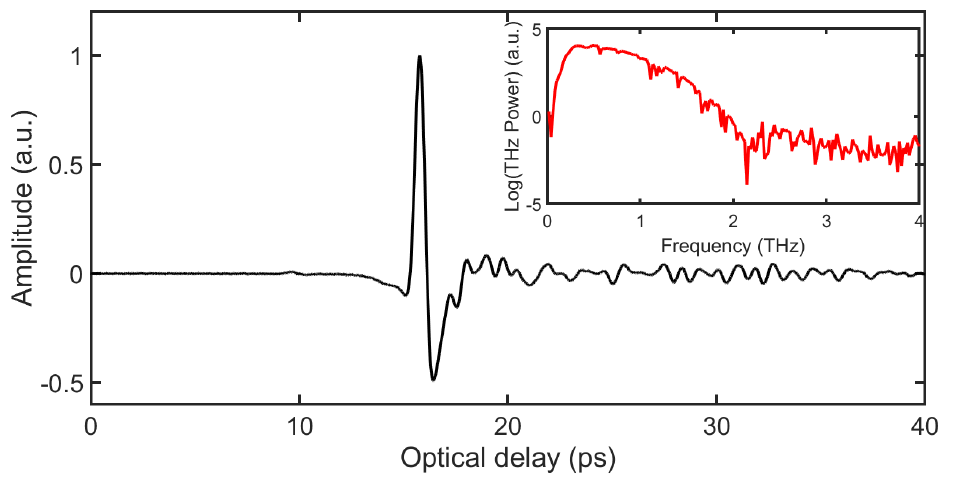
Figure 1. THz reference signal with its frequency spectrum in the inset.